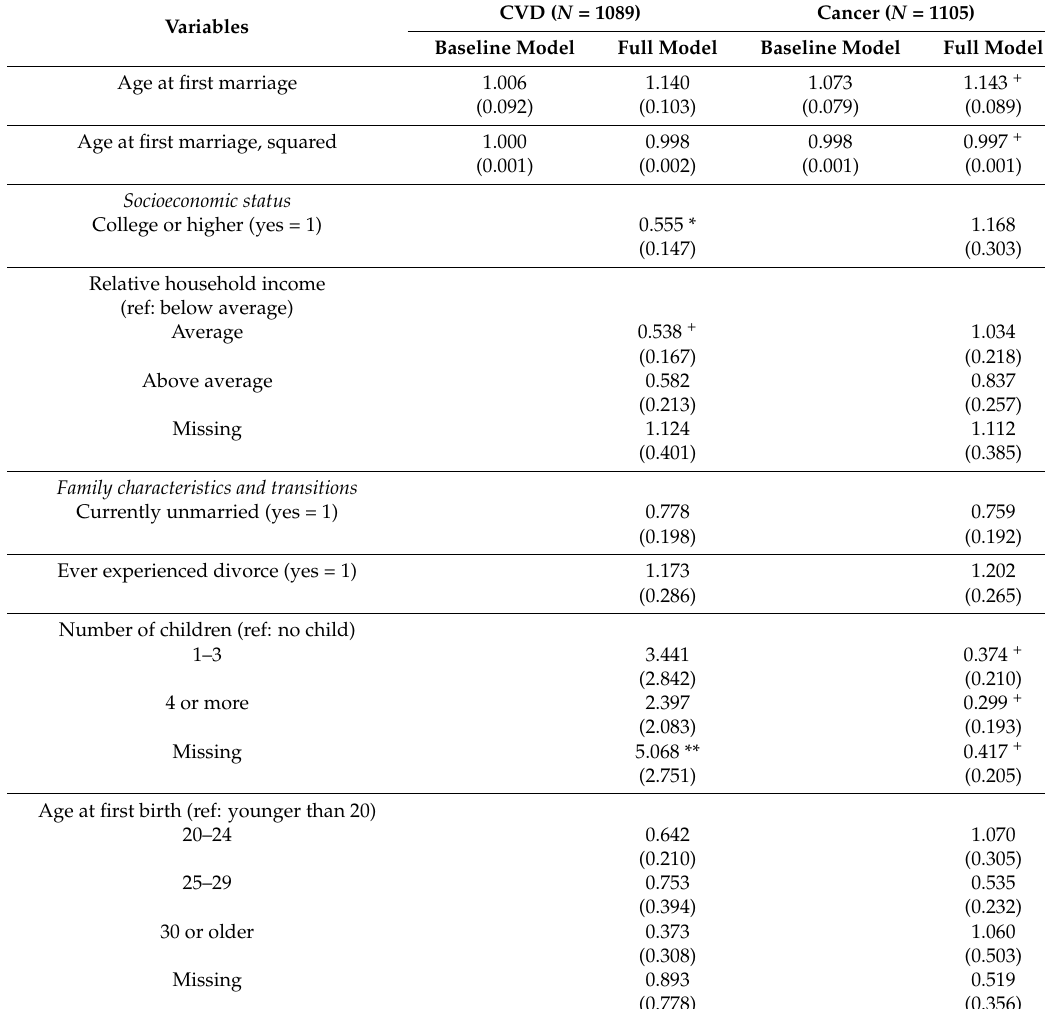
Table 3. Estimated Odds Ratios of CVD and Cancer by Age at First Marriage,